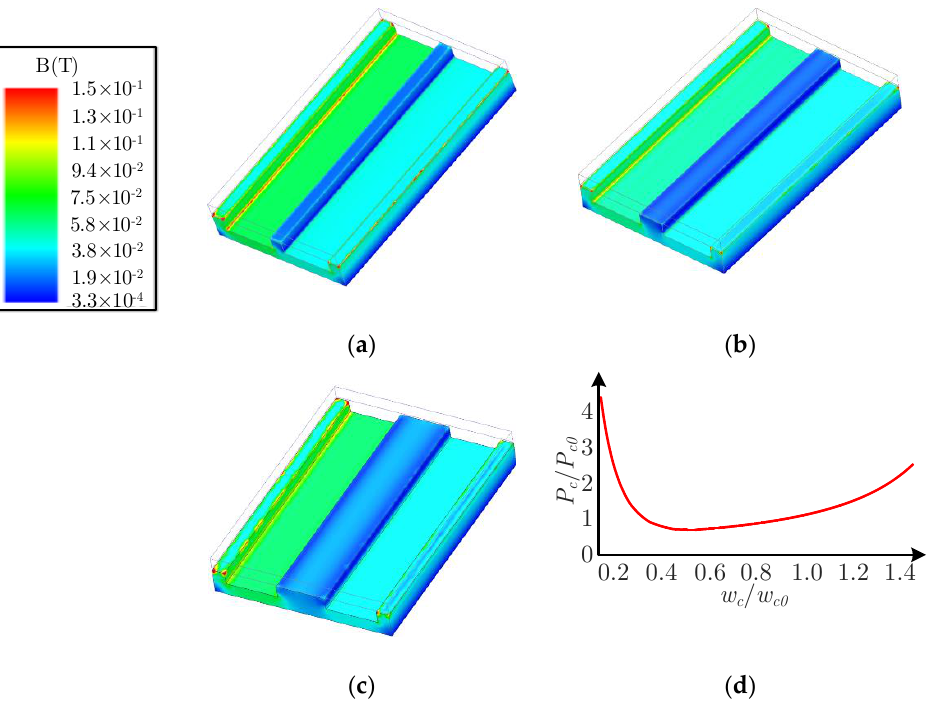
Figure 8. Distribution of magnetic flux density with different w c : ( a ) w c = 5.2 mm; ( b ) w c = 10.4 mm; ( c ) w c = 20.8 mm; ( d ) core loss with w c